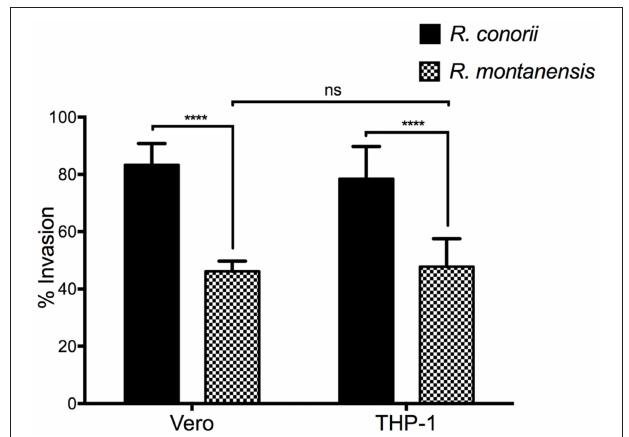
FIGURE 4 | Invasion rate of R. montanensis into THP-1-derived macrophages is not affected when compared with Vero cells. PMA-differentiated THP-1 cells and Vero cells were infected with R. montanensis and R. conorii (MOI = 10). After 60 min of infection, cells were fixed and processed for differential staining to distinguish between extracellular and intracellular rickettsiae. Results are expressed as percentage of internalized rickettsiae. At least 200 host nuclei were counted for each experimental condition. Results are shown as the mean ± SD (ns, non-significant, **** P <